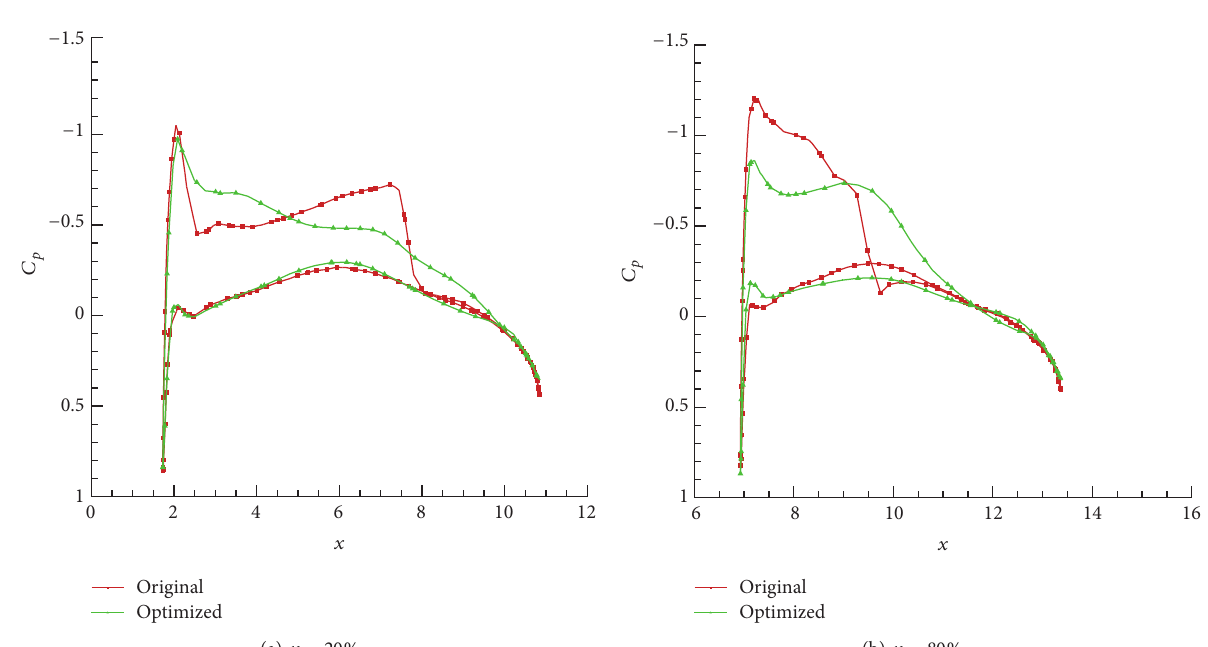
Figure 7: Comparison of section pressure coefficients before and after design of ONERA M6.